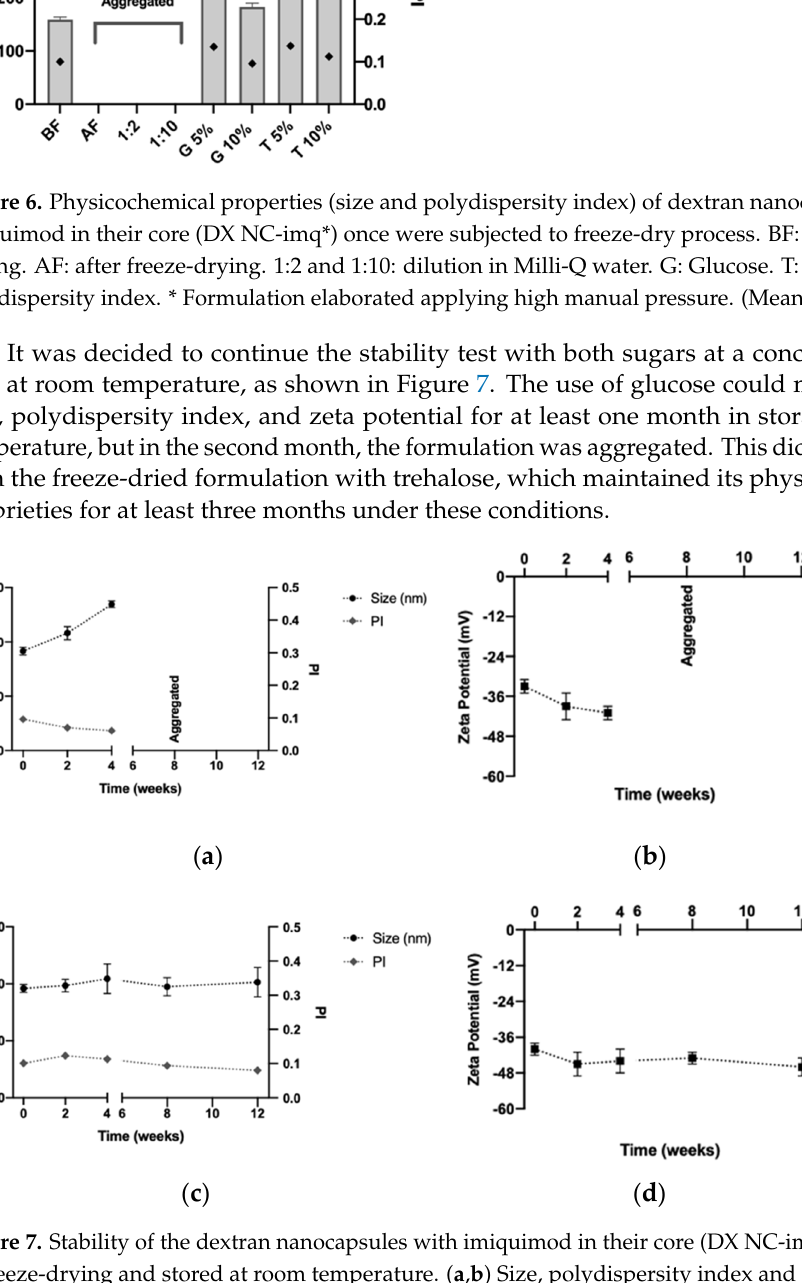
Figure 6. Physicochemical properties (size and polydispersity index) of dextran nanocapsules with imiquimod in their core (DX NC ‐ imq*) once were subjected to freeze ‐ dry process. BF: before freeze ‐ drying. AF: after freeze ‐ drying. 1:2 and 1:10: dilution in Milli ‐ Q water. G: Glucose. T: Trehalose. PI: polydispersity index. * Formulation elaborated applying high manual pressure. (Mean ± SD, n = 3).